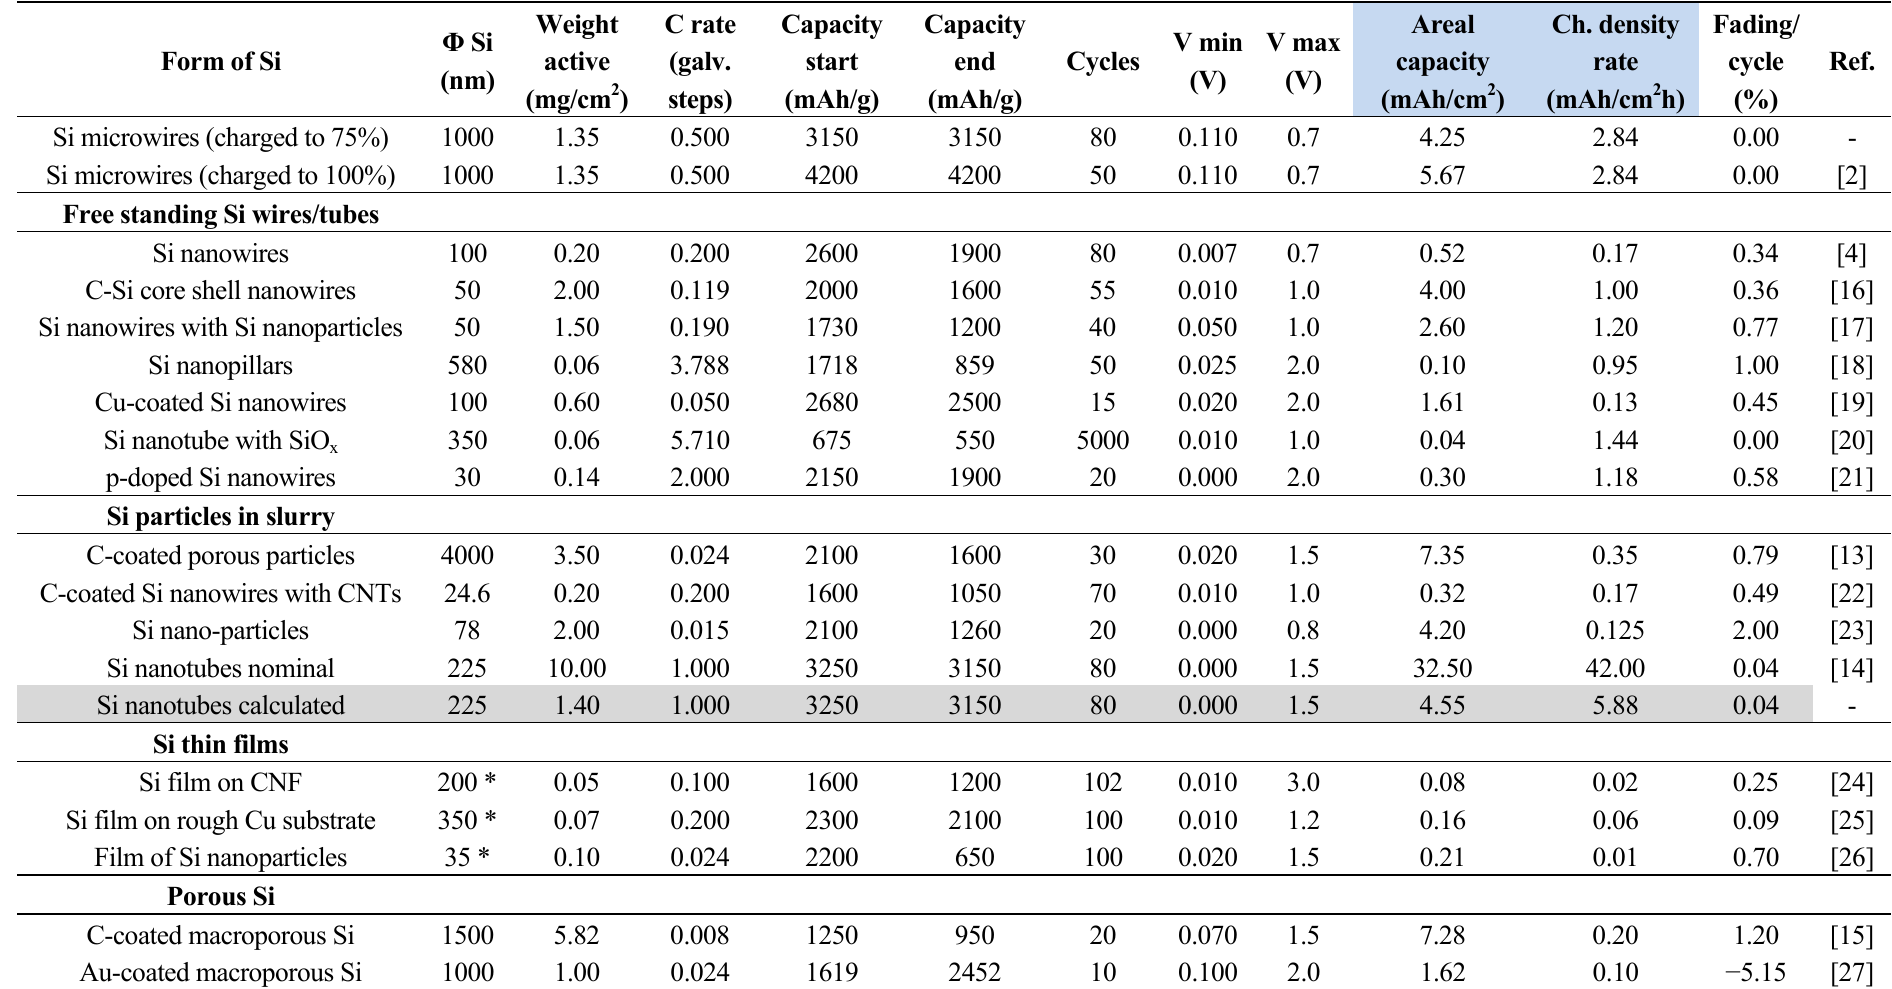
Table 1. Half-battery cell parameters of different Si anode